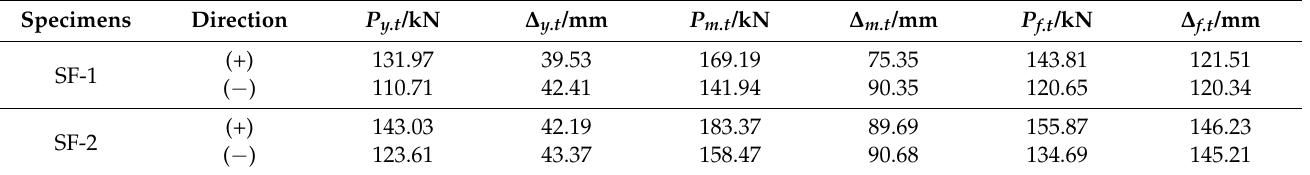
Table 4. Characteristic points in the skeleton curves of SF-1 and